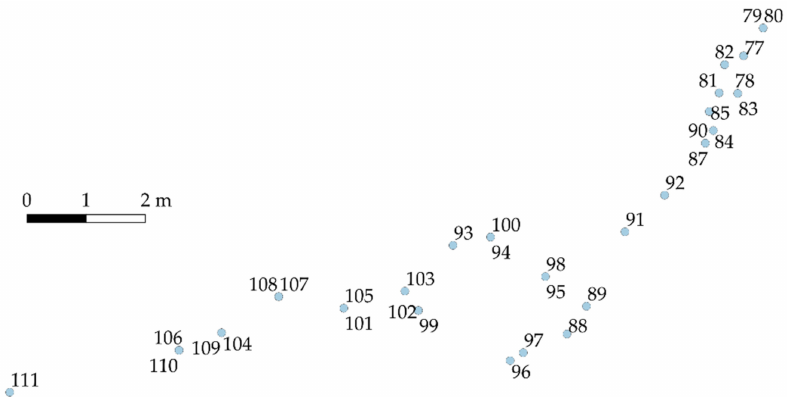
Figure 5. Example of the StemNumbers of individual harvester location points. The StemNumbers correspond, in principle, with the felling order of trees, but sometimes they can vary with respect to the course of the strip road. In this example, the harvester drove from top right to the left. Note the scale of the